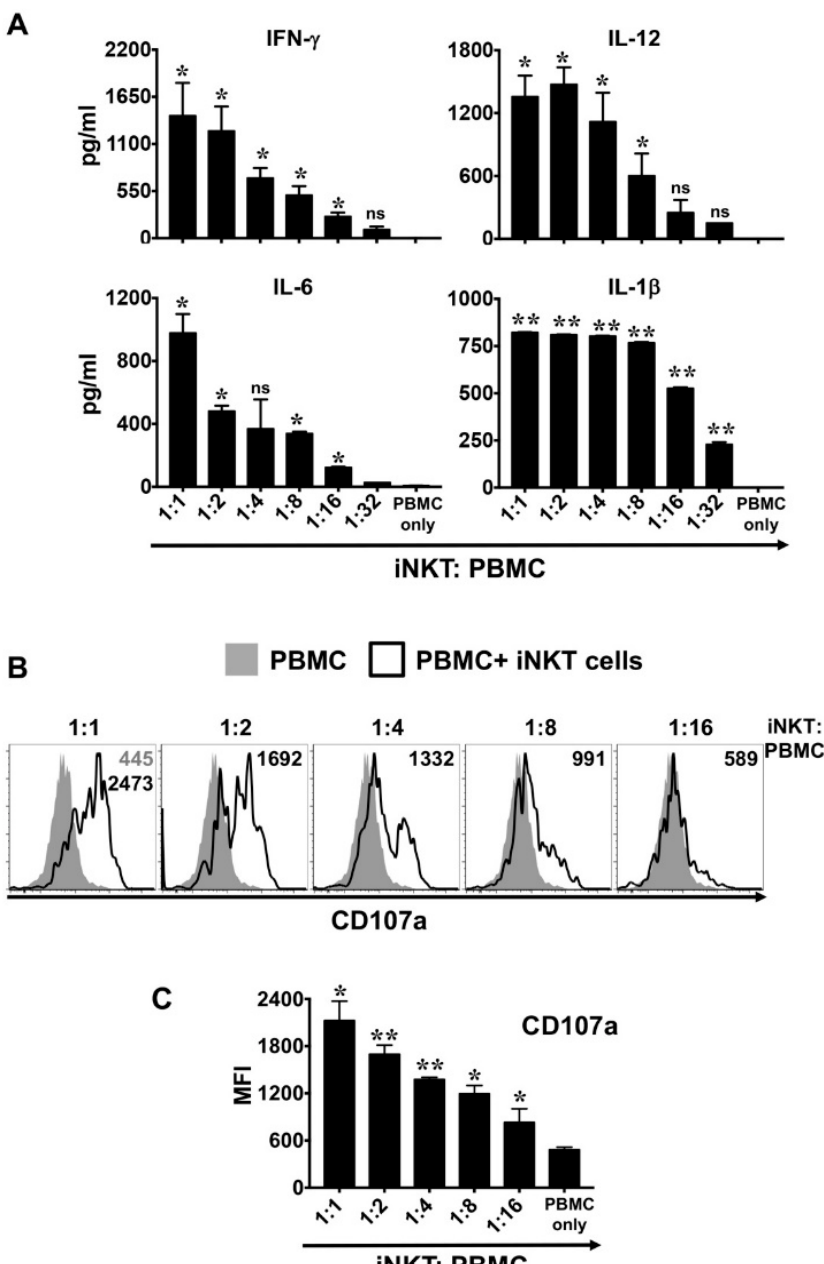
Figure 6. NKTT320 induces bystander cell cytokine production and NK cell degranulation in vitro. Freshly isolated human iNKT cells were mixed with autologous PBMCs at di ff erent ratios, as indicated. Control wells had PBMCs only. Cells were added to plate-bound NKTT320 mAb (1.0 µ g / mL). After 24 h, cells and culture supernatants were harvested and analyzed for various cytokines by ELISA ( A ) and CD107a expression on NK (CD56 + TCR β -) cells, respectively. Cytokine levels (mean ± SEM) in culture supernatants from three independent experiments are presented. Representative histograms (in ( B )) are from one of three independent experiments. Numbers in the histograms indicate MFI. ( C ) Pooled data (mean ± SEM) from three independent experiments showing MFI for CD107a expression on CD56 + cells. Statistical significance in ( A , C ) was determined using one-way ANOVA. For each of the analysis, all the groups were compared to control wells (PBMC only). * p < 0.05, ** p < 0.01, ns: not